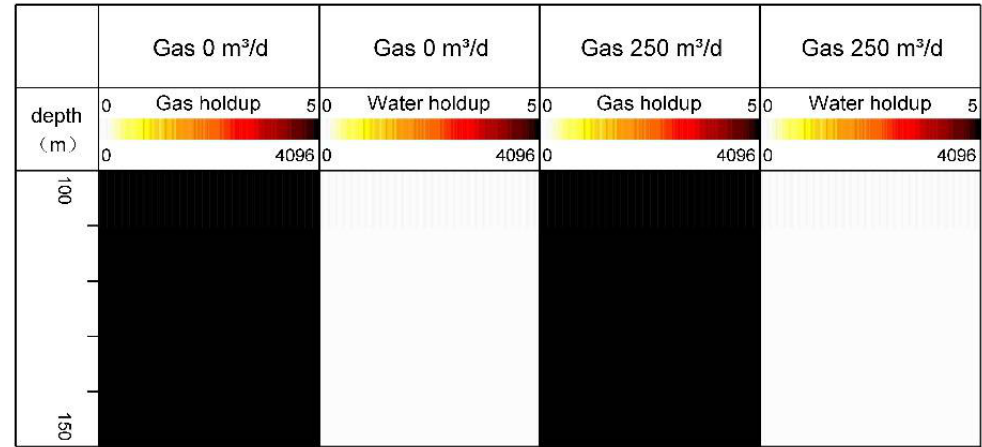
Figure 2. Response characteristics of pure gas at 0 and 250 m 3 /d.